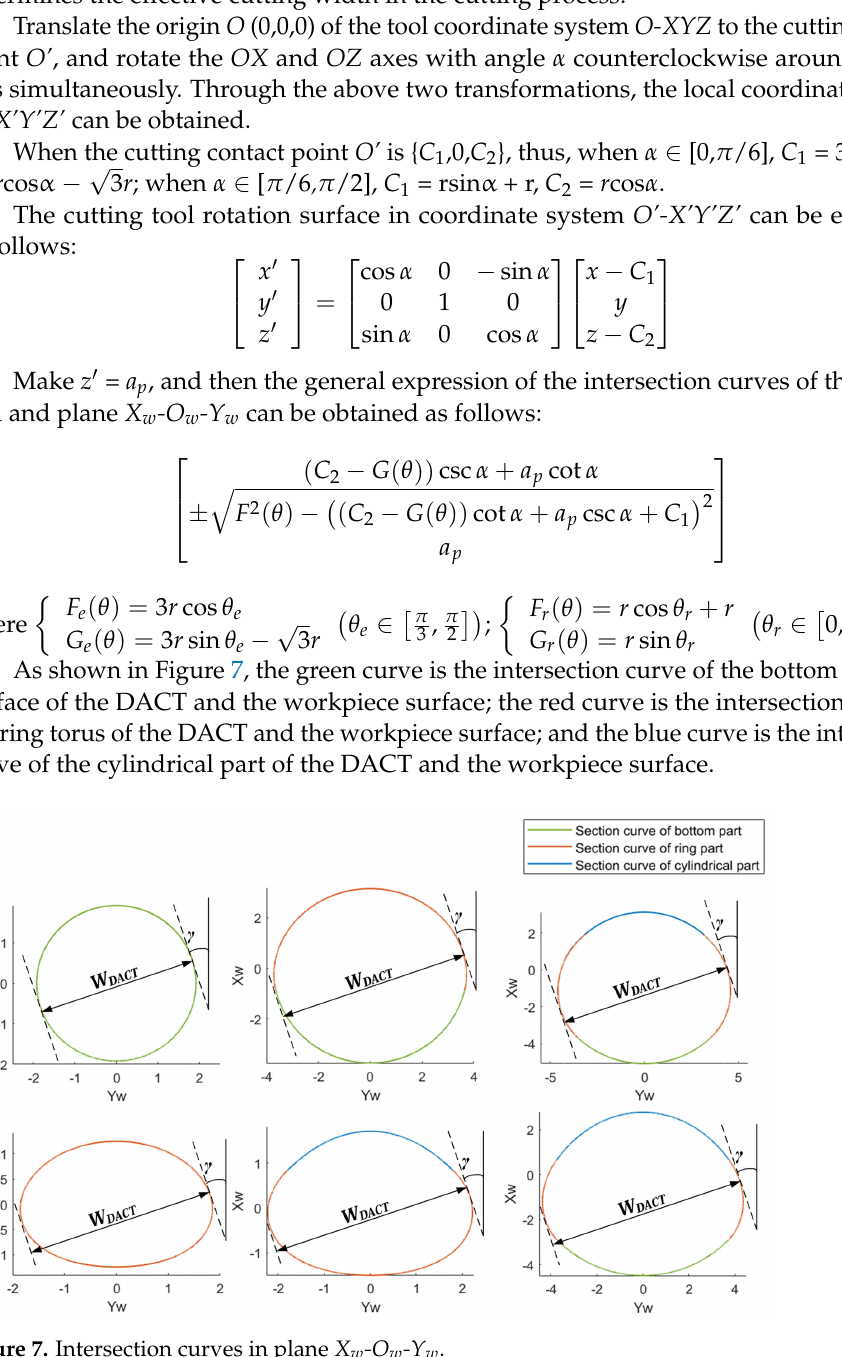
Figure 7. Intersection curves in plane X w -O w -Y w . The included angle γ between the feed direction of the cutting tool and the X w axis, the geometric parameter r , the inclination angle α , and the cutting depth a p are the main factors that affect the effective cutting width of the DACT, as shown in Figure 7. When only the bottom spherical part is involved in the cutting, the effective cutting width of the DACT is: